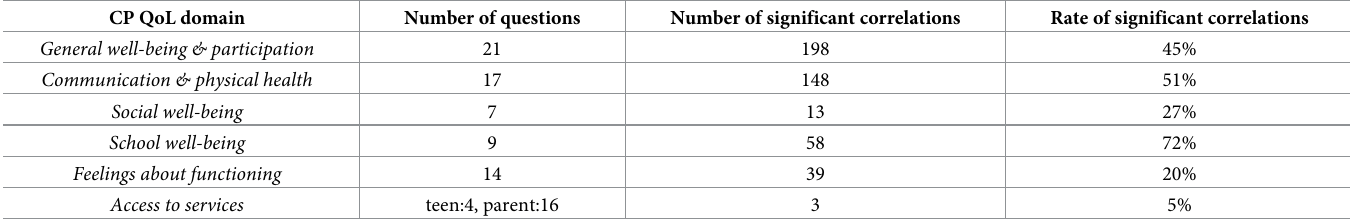
gave a more positive assessment. The strongest positive correlation was between the items Table 3. Differences between adolescents’ and parents’ domains in the Pannonian